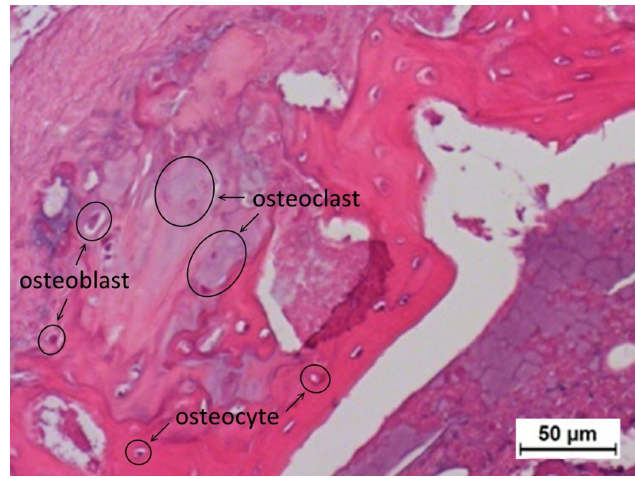
Figure 8. Representative histological image between the L4 and L5 transverse processes stained with haemotoxylin and eosin at four weeks post-surgery of the DCP-rich CPC supplemented with 0.4 mL collagen (200×). Osteoblasts are single-nucleus cells, found on the surface of bones, and separated from each other by their underlying matrix. Osteoclasts are characterized as large cells with multiple nuclei and ‘foamy’ cytosols. Scale bar = 50 μ m.